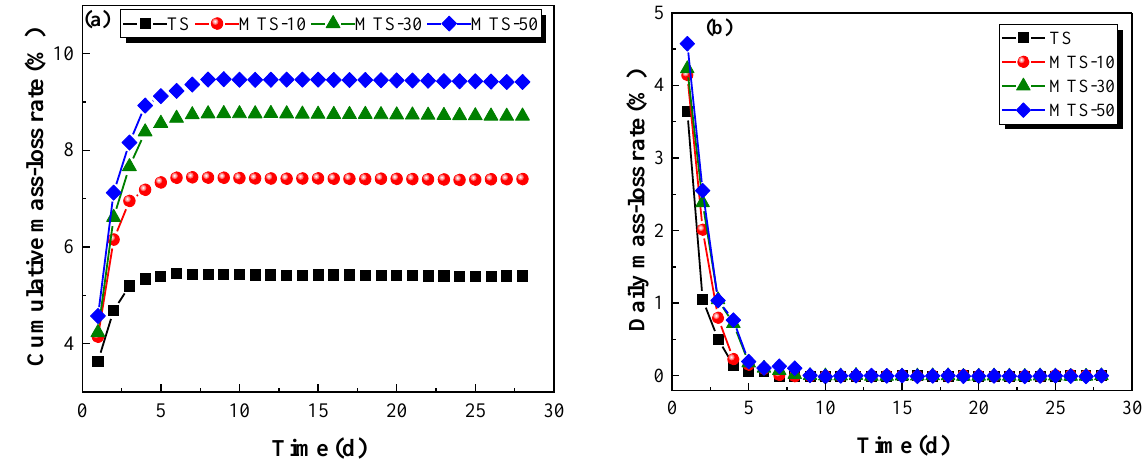
Figure 17. ( a ) Cumulative mass loss rate; ( b ) daily mass loss rate.